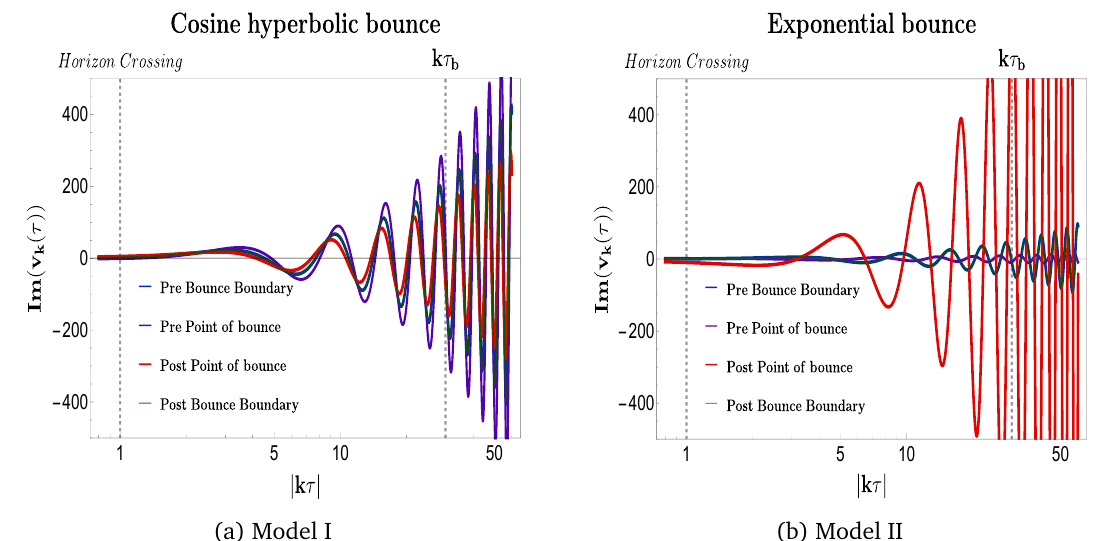
Figure 8: The imaginary part of v for the Cosine hyperbolic and the exponential k bounce has been plotted. We can see the behaviour of v in the sub-horizon region k | k τ | (cid:29) 1. Around the Horizon crossing, the Im ( v ) starts off positive for the Cosine k hyperbolic bounce, whereas it starts off negative for the exponential bounce. Far from the horizon crossing, the behaviour of both the models are almost identical. It slowly starts rising before becoming highly oscillatory with increasing amplitude and ≈ 30. The field variables in all frequency as they approach the point of bounce k τ b regions behave almost similarly. However a noticeable difference between the two models lies in the fact that the amplitude of the field variable for a particular region is in contrast for both the models. If the amplitude is maximum for a particular region for model-I, then it is minimum for